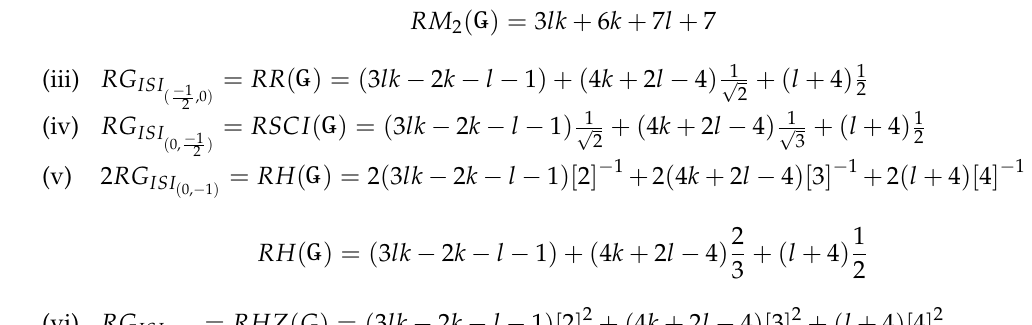
Table 1. Some reverse degree-based topological descriptors derived from the reverse general in- verse sum indeg descriptor.